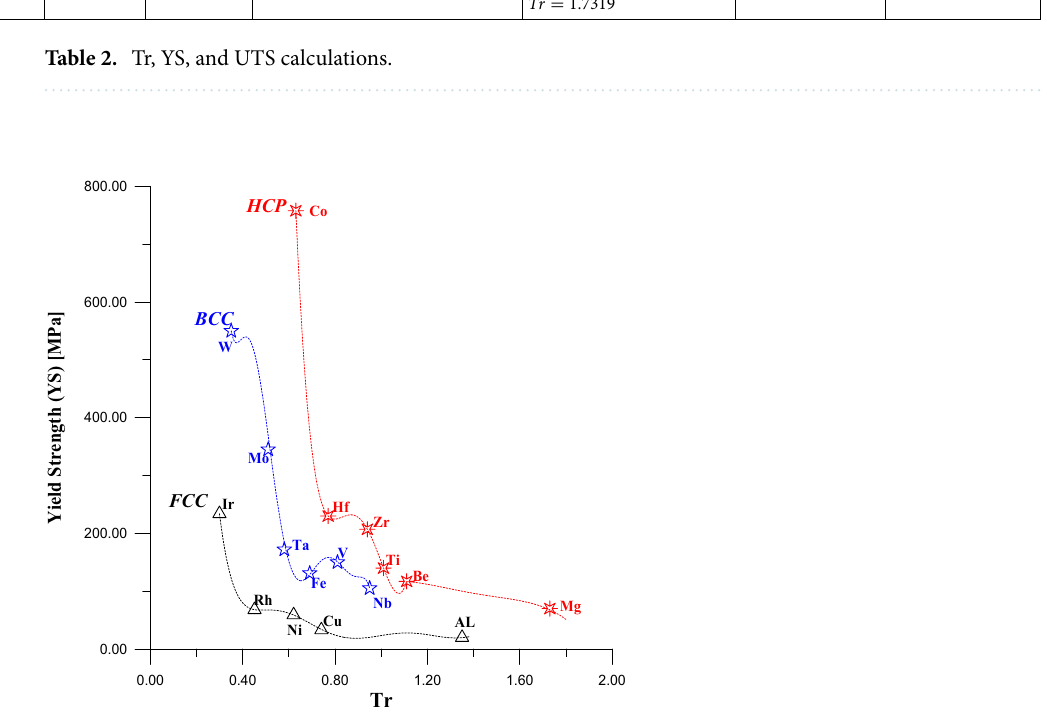
Figure 7. A comparison in values of yield strength among FCC, BCC, and